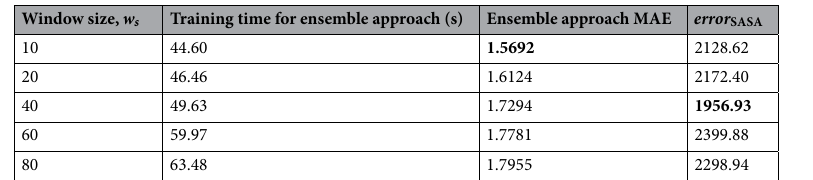
Table 1. The impact of different window size values, w s . The lowest values are in bold.